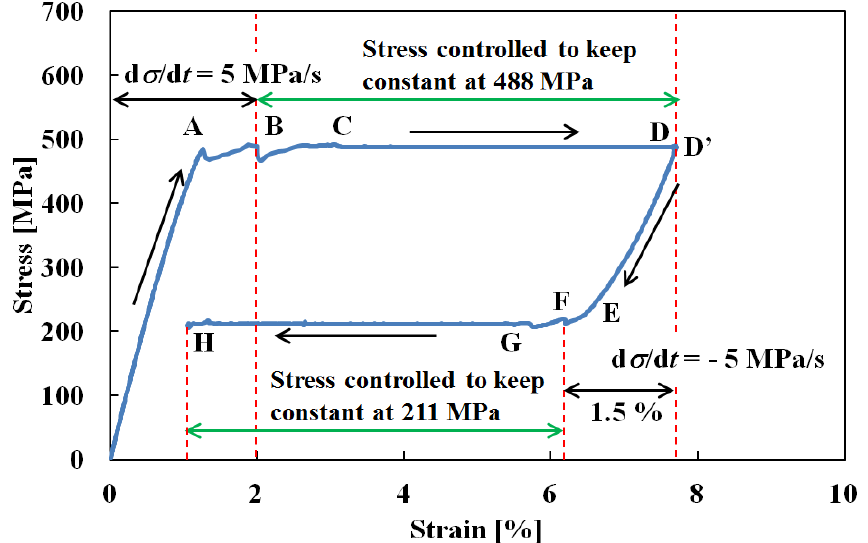
Figure 10. Stress-strain curve under stress rate of d σ /d t = 5 MPa followed by stress keeping from a strain of 2% during loading and stress keeping from decrease in strain of 1.5% from the maximum strain during